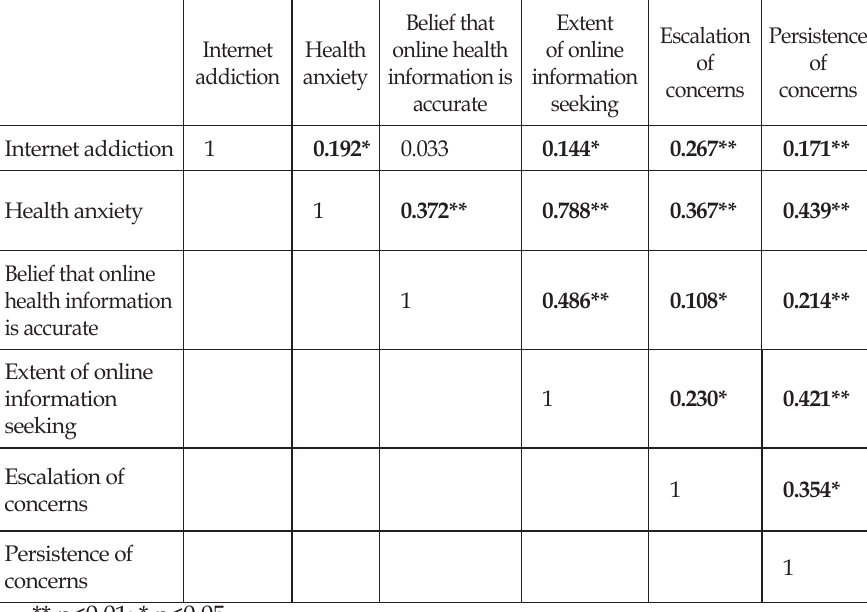
Extent Belief that of online health Health information is